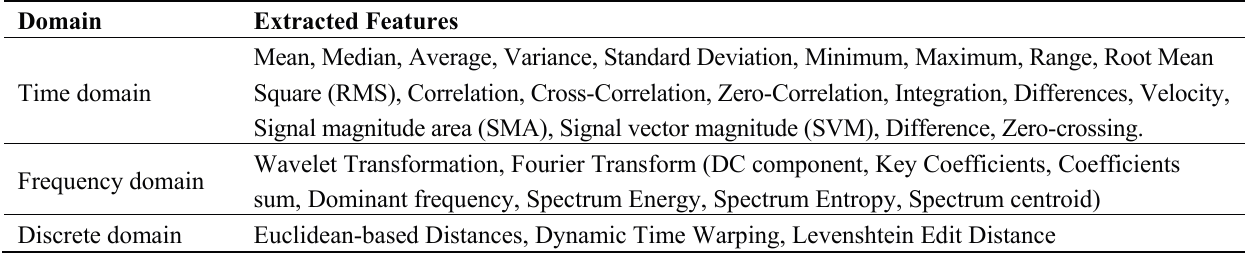
Table 6. Taxonomy of extracted features in three